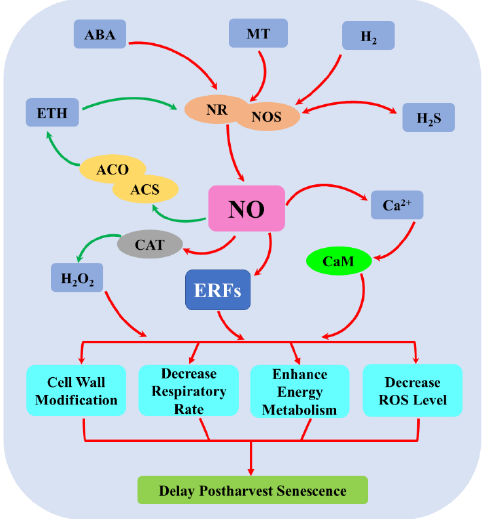
Figure 4. The crosstalk between NO and other molecules. ABA, abscisic acid; ACO, 1-aminocyclopropane-1-carboxylic acid oxidase; ACS, 1-aminocyclopropane-1-carboxylic acid synthase; Ca 2+ , calcium ion; CAT, catalase; CaM, calmodulin; ERFs, ethylene response factors; ETH, ethylene; H 2 O 2 , hydrogen peroxide; H 2 S, hydrogen sulfide; H 2 , hydrogen gas; MT, melatonin; NO, nitric oxide; NOS, nitric oxide synthase; NR, nitrate reductase. Red arrow indicates promotion; green arrow indicates inhibition; red two-way arrow indicates synergistic role; green two-way arrow indicates antagonistic role.